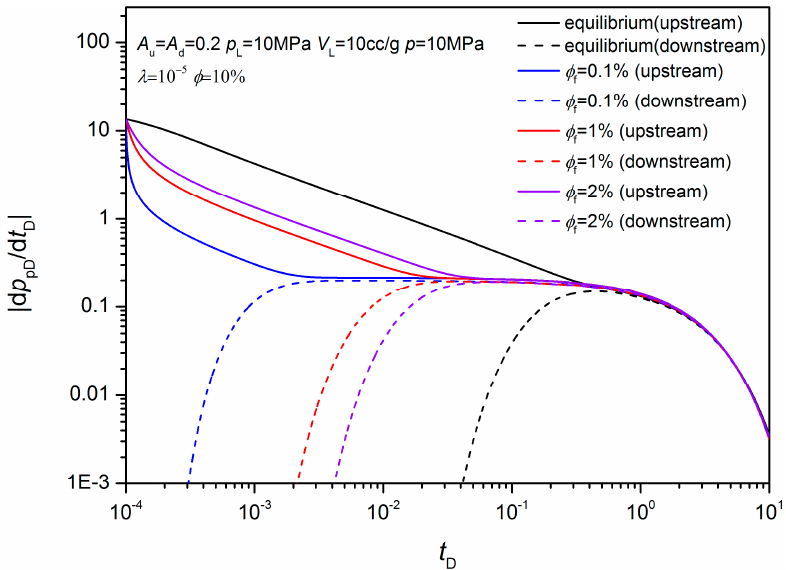
Figure 17. The pseudo-pressure derivative at the early stage.